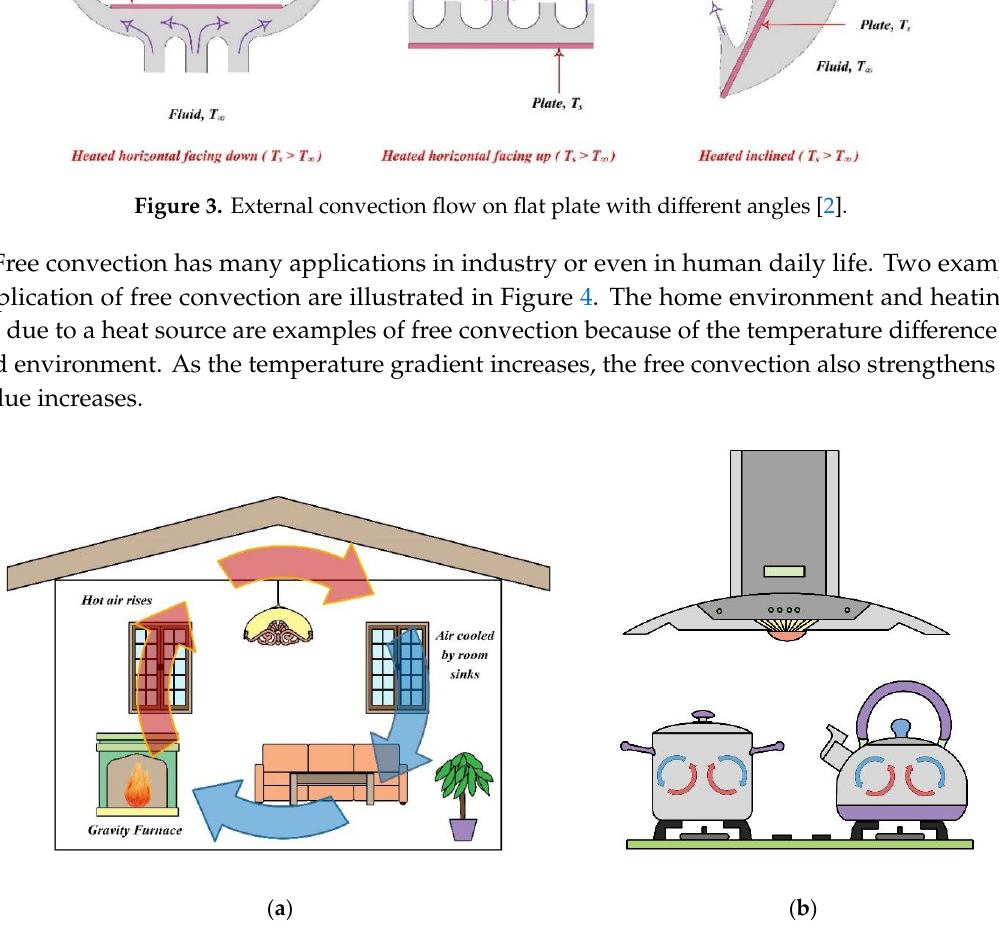
Figure 4. An example of some applications of free convection. ( a ) home environment, ( b ) heating of water [2].